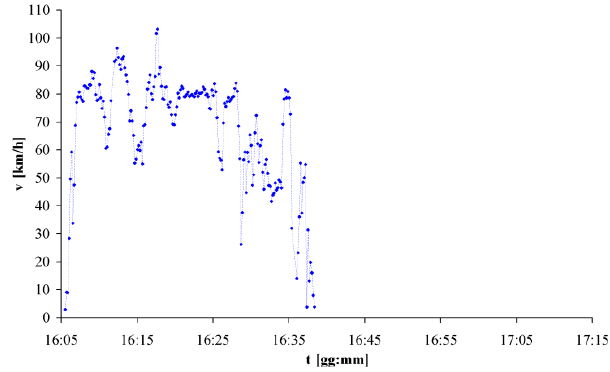
Fig. 12. Speed and time of day during the exemplary run of the second part of the route